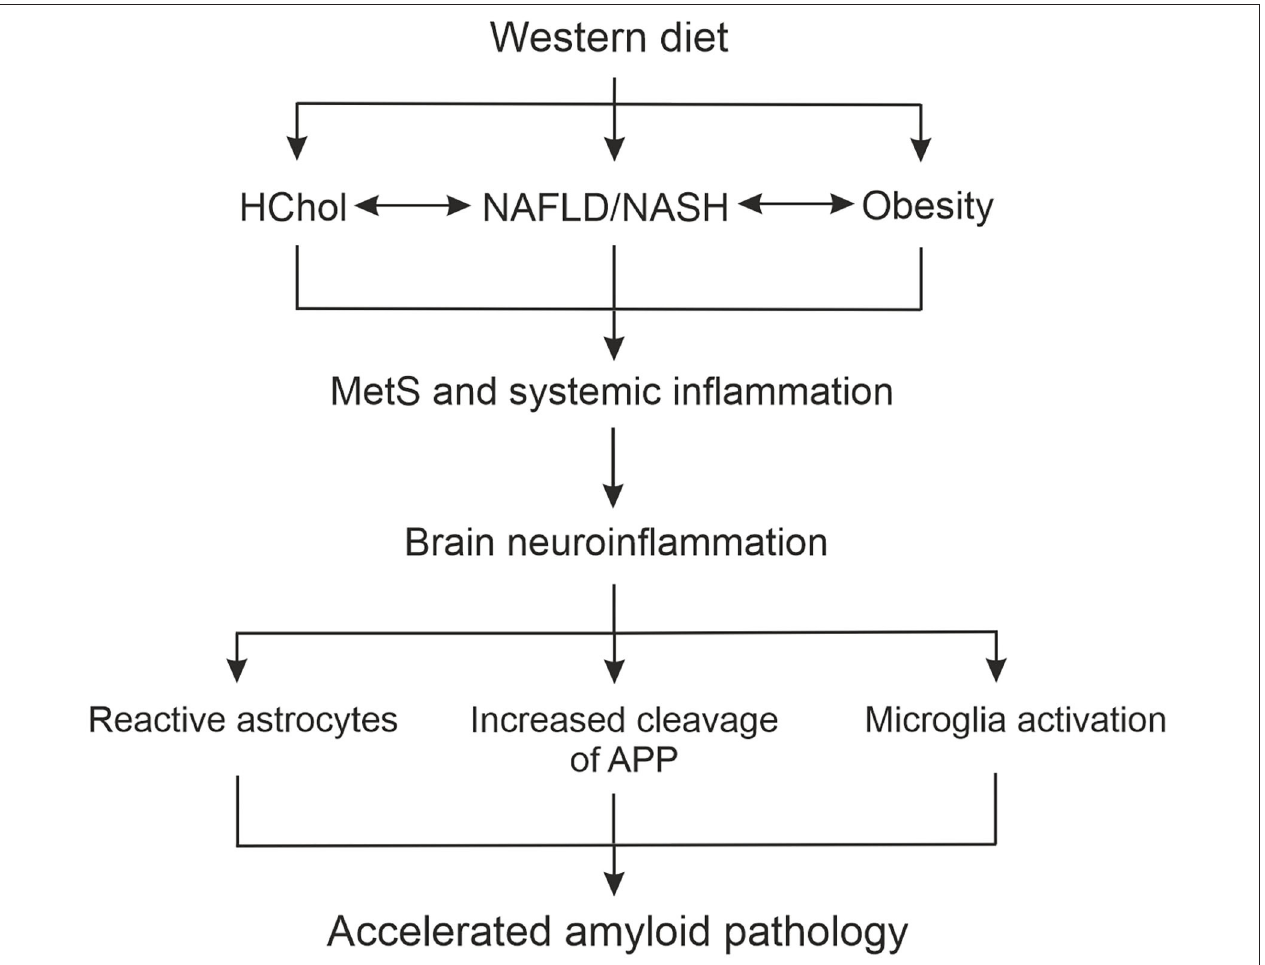
FIGURE 9 | Scheme summarizing the role of liver function in the relationship between WD-induced metabolic and systemic disturbances, and neuropathological changes in the brain leading to accelerated AD development. APP, amyloid precursor protein; HChol, hypercholesterolemia; NAFLD, non-alcoholic fatty liver disease; NASH, non-alcoholic steatohepatitis; MetS, metabolic